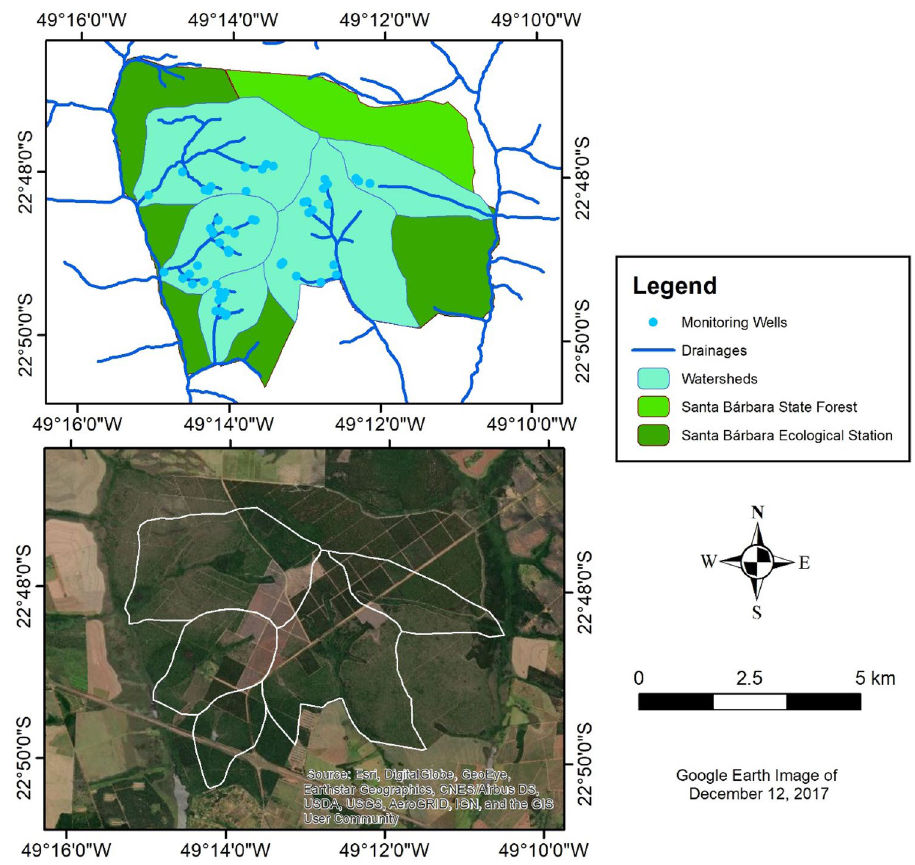
Fig. 4 Water table monitoring network along four watersheds